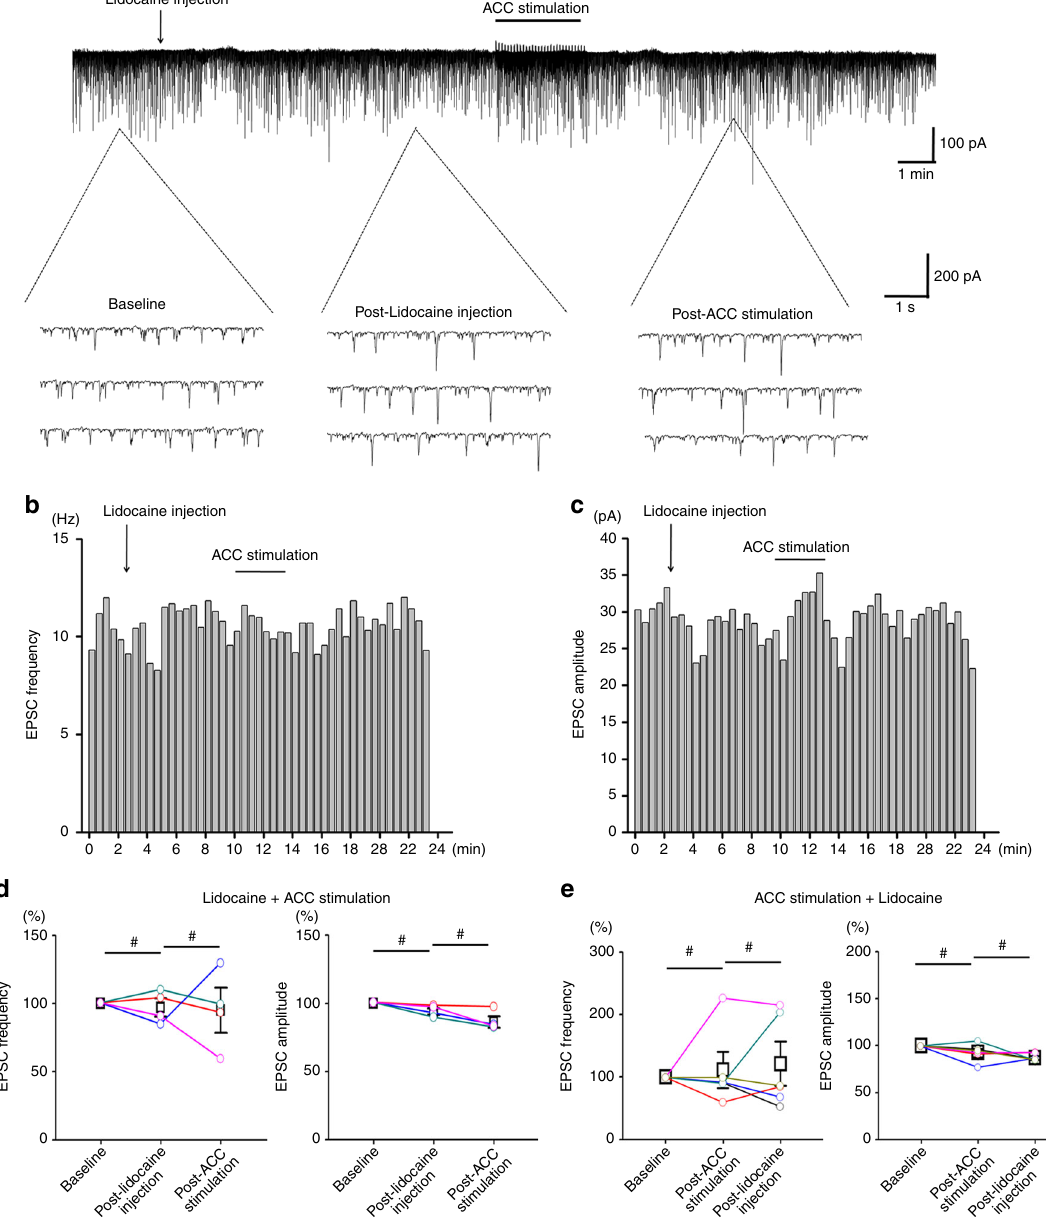
Fig. 5 RVM blockade and ACC stimulation did not affect the spinal sEPSC in SNI rats. a – c One sample ( a ) and the histogram fi gures showing the frequency ( b ) and amplitude ( c ) of the spinal sEPSC was not affected by lidocaine blockade of RVM and following ACC stimulation. d Summarized results from 4 SDH neurons with lidocaine injection and ACC stimulation. e Summarized results from 4 SDH neurons with ACC stimulation and following lidocaine injection. # p >